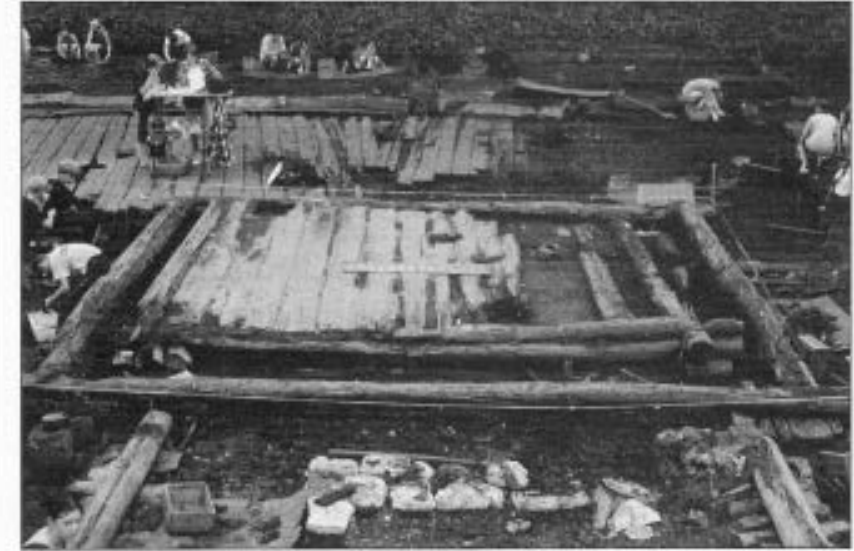
Figure 5 The later of the two mid-twelfth-century buildings excavated by the UCL team in Troitsky XII, showing its plank floor (scale bar 1.5m}. out by the presence ofboth primary (rough­ ing-out) waste and secondary (finishing) waste in the